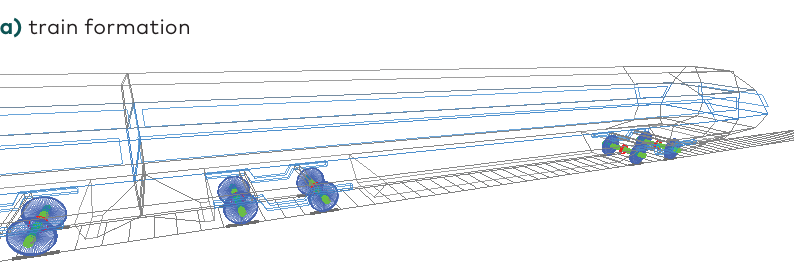
Figure 8. Train model in SIMPAK